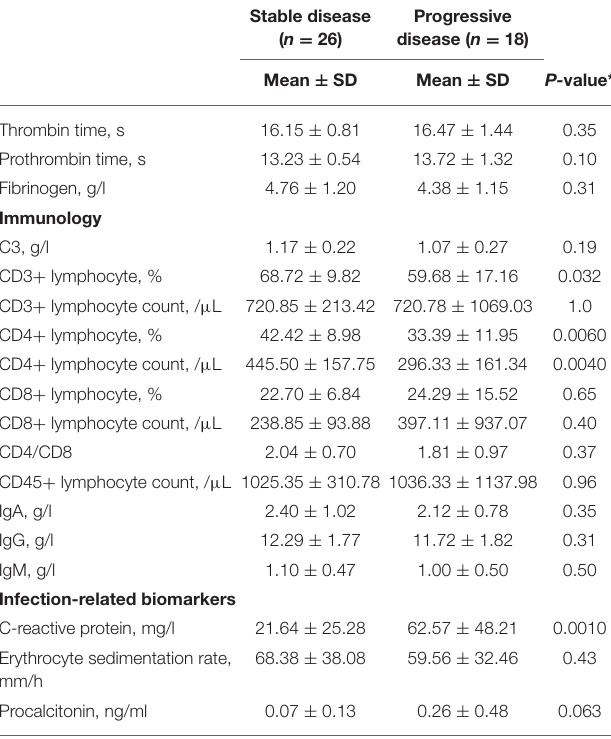
TABLE 4 | Comparison of Laboratory examination between mild and moderate patients with or without progressive disease.